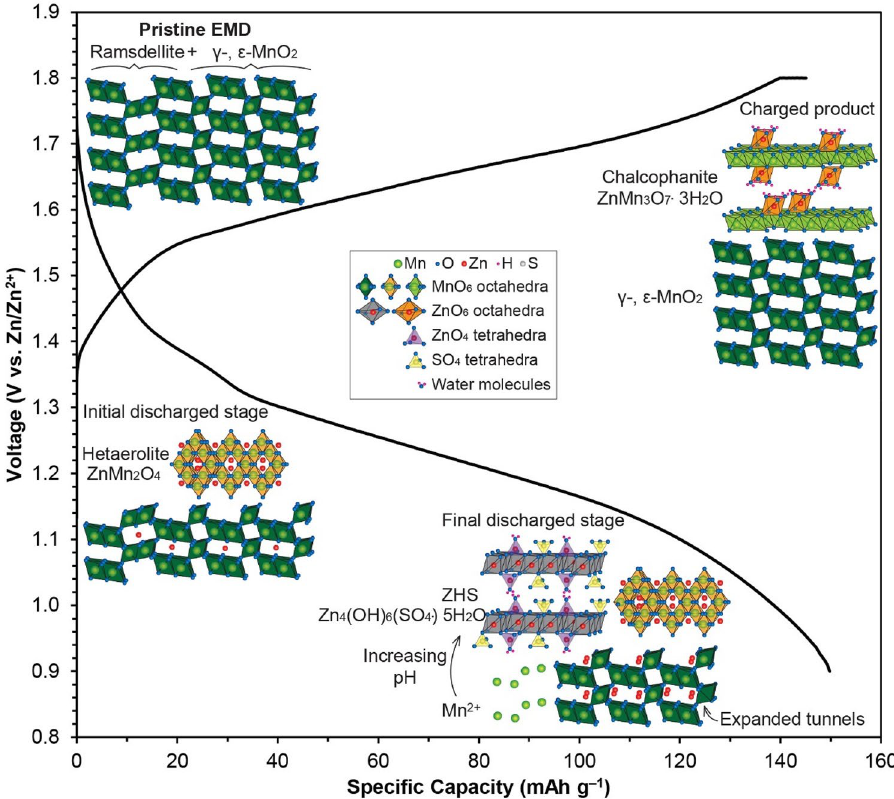
Figure 7. Schematic illustration of the proposed charge/discharge process for